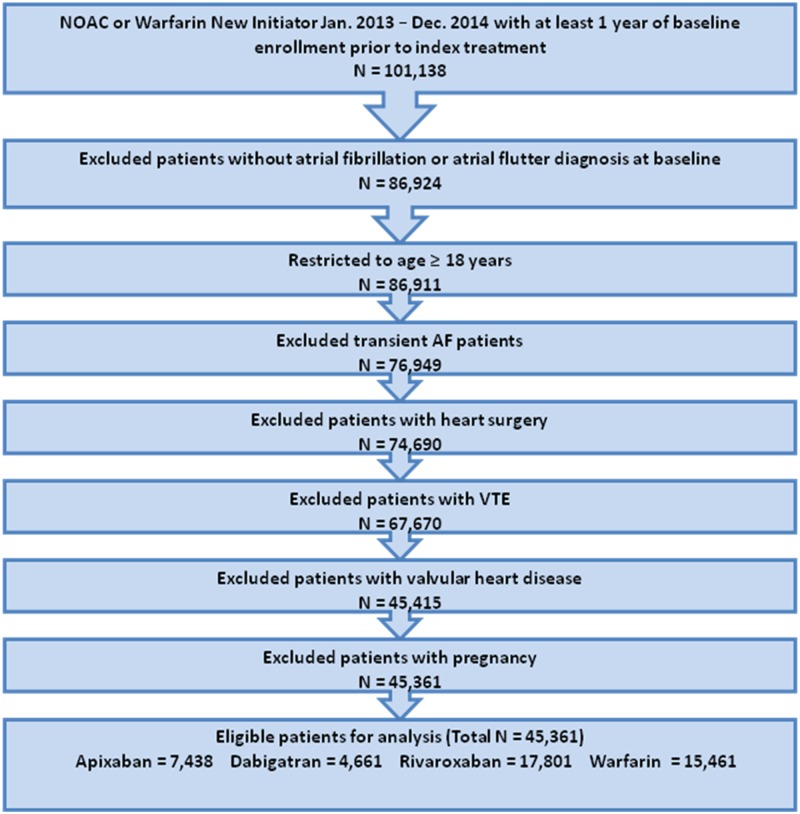
Patient selection criteria.Study population flow chart with inclusion and exclusion criteria used to select 45,361 patients. NOAC: non-vitamin K antagonist oral anticoagulant; VTE: venous thromboembolism.